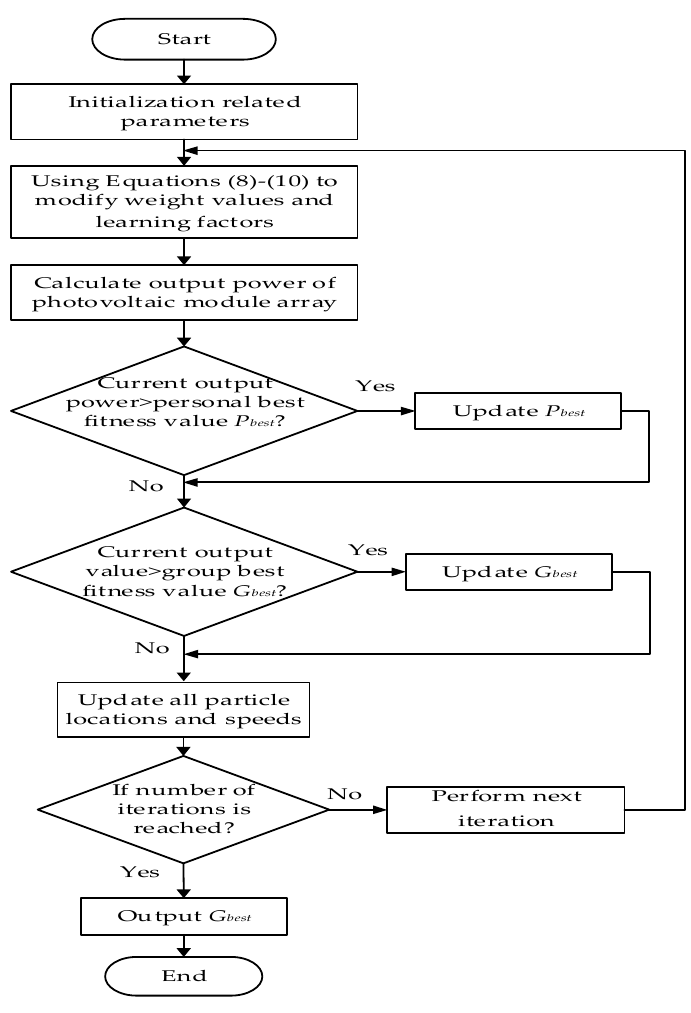
Figure 6. Flowchart combining ABC and PSO.